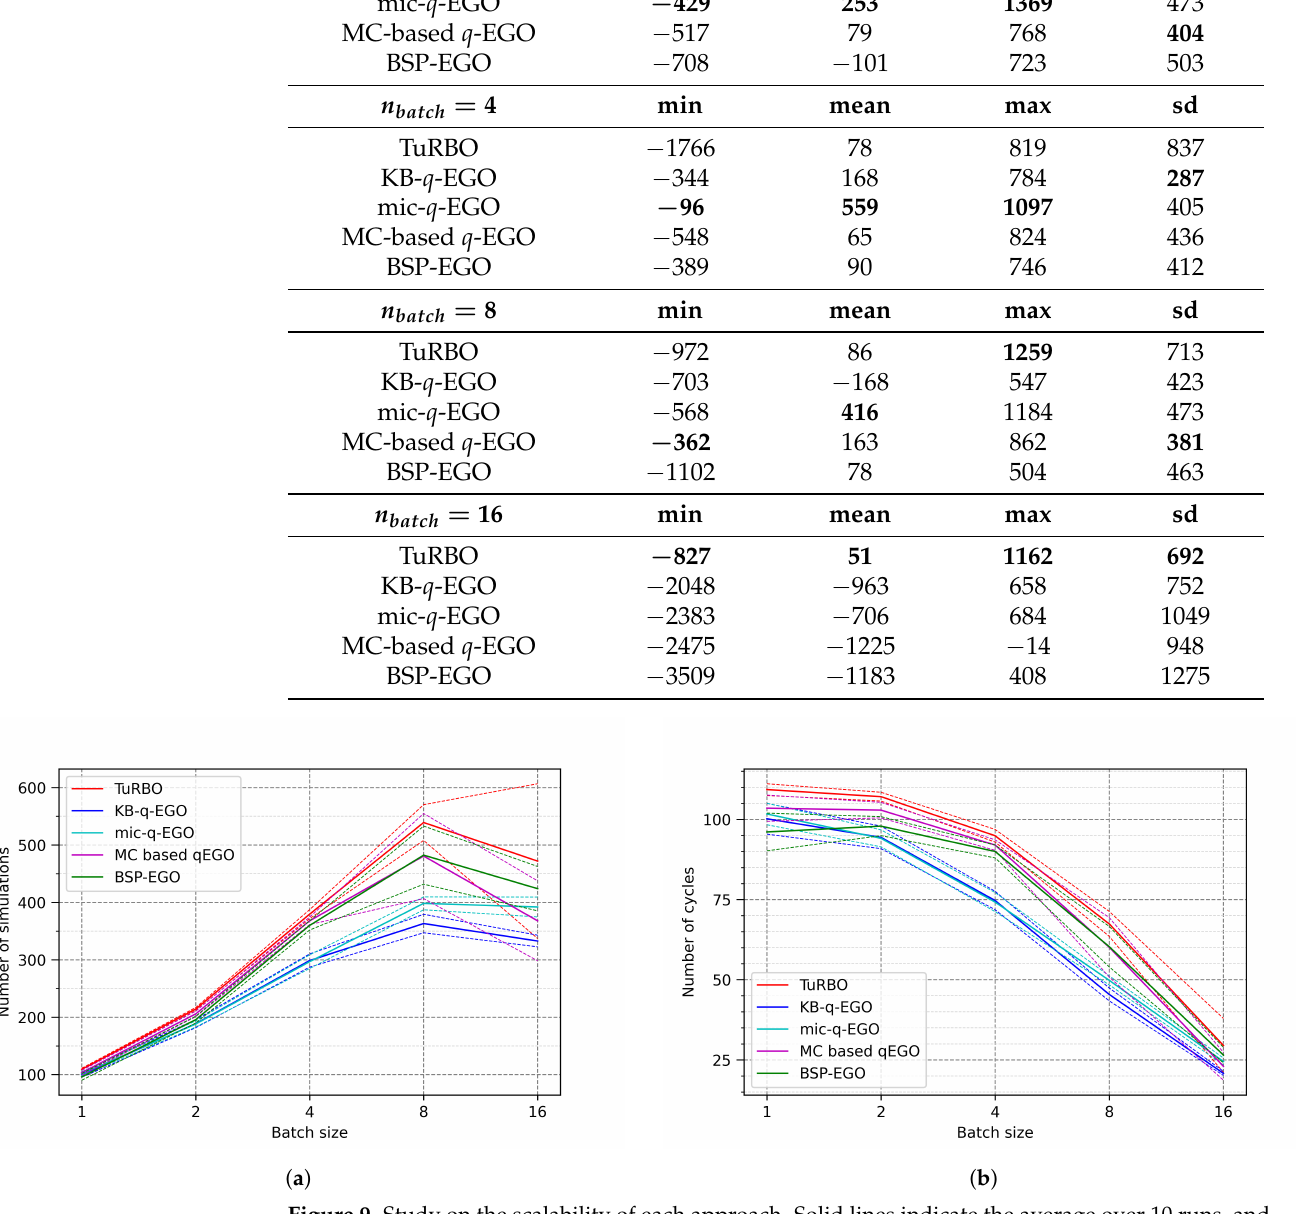
Figure 9. Study on the scalability of each approach. Solid lines indicate the average over 10 runs, and dashed lines of same colors indicate the standard deviation. ( a ) Number of simulations as a function of the batch size. ( b ) Number of cycles as a function of the batch